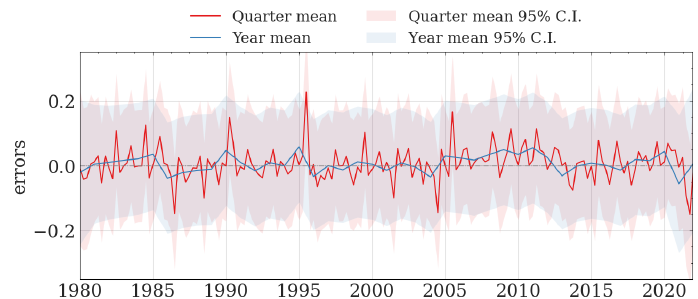
Figure 14. The quarterly and yearly mean of the residual.